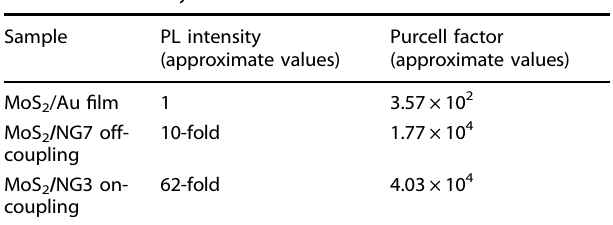
Table 1. PL intensity and Purcell